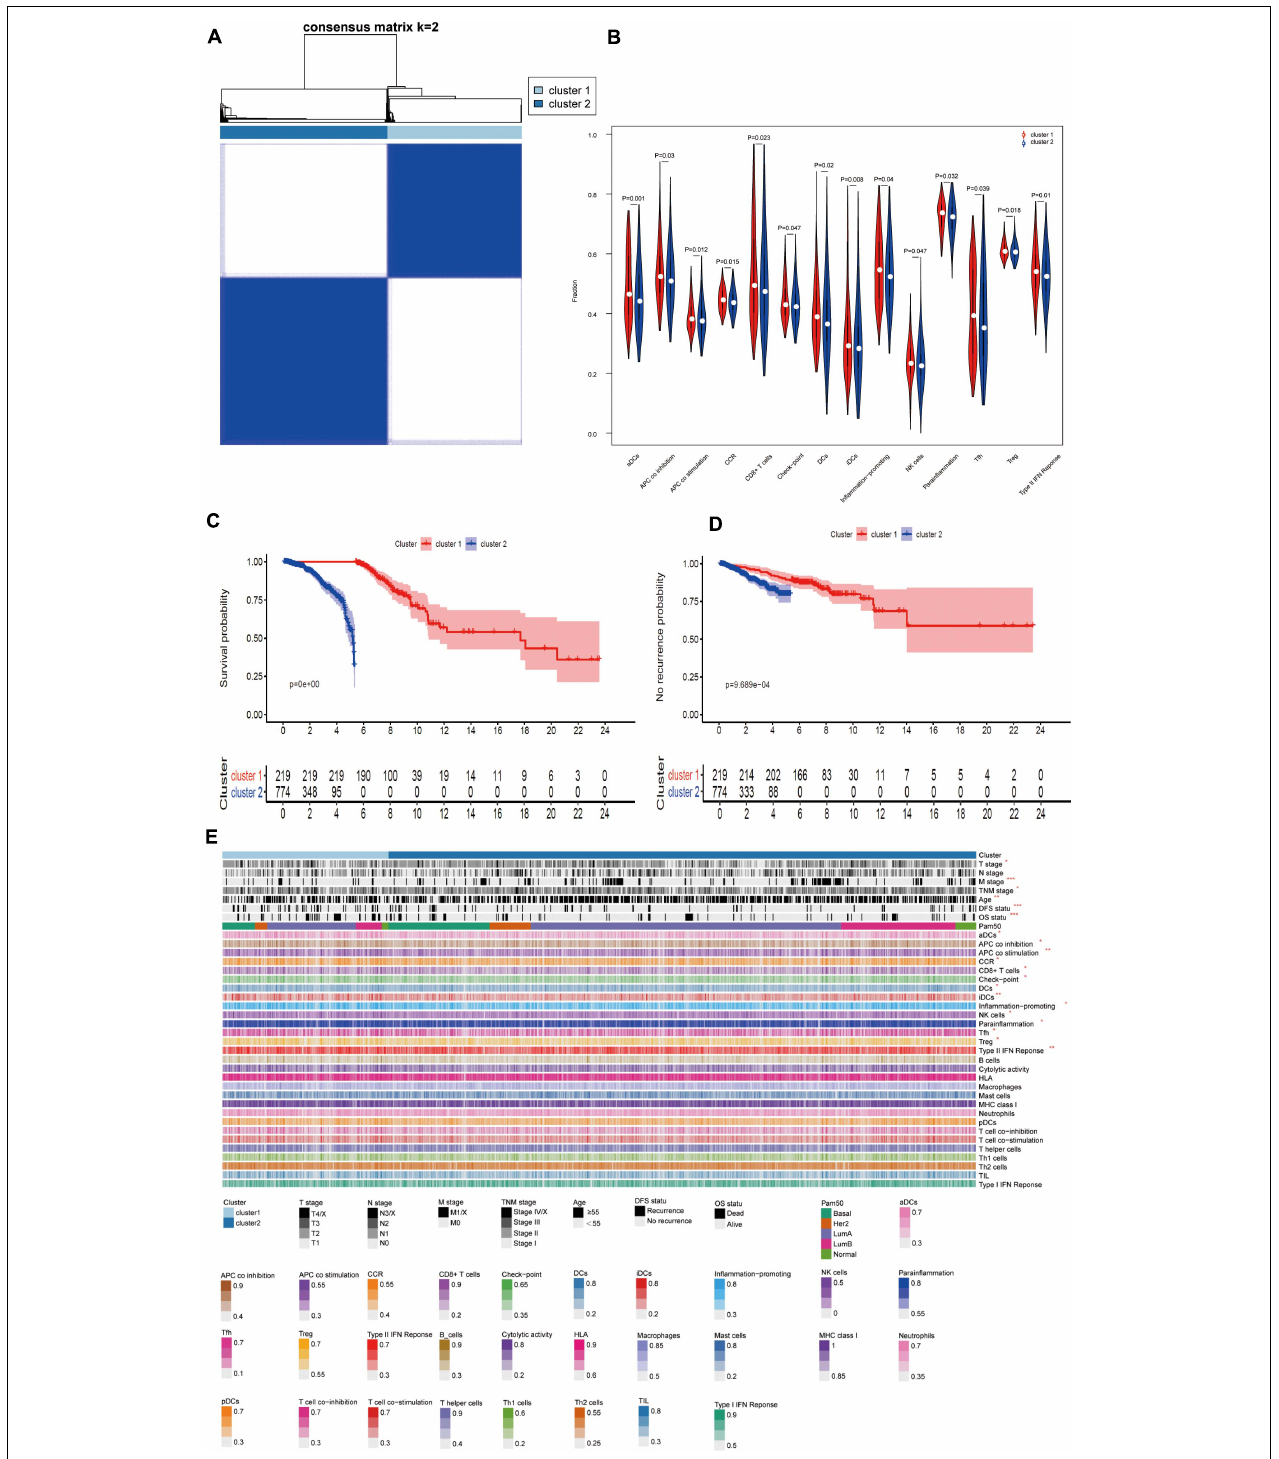
FIGURE 5 | (A) Consensus cluster analysis identified two clusters (sample, n = 993). Heat maps of white (consensus = 0, samples never come together) and blue (consensus = 1, samples always come together) show sample consensus. (B) Violin diagram of immune-related components between; cluster 1 and 2. (C,D) Kaplan-Meier survival analysis for different molecular clusters based on OS or DFS; (E) Cluster analysis of clinicopathological information and immune components. (* P < 0.05 and =0.01; ** P < 0.01 and =0.001; *** P < 0.001).